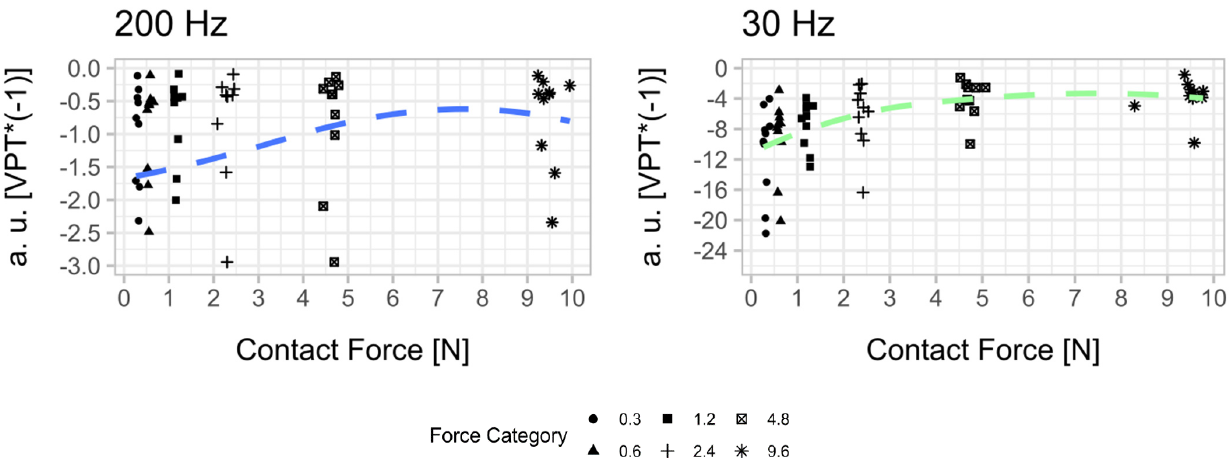
Figure A2. Psychophysical relationship between contact force and perceived sensitivity [VPT*( − 1)] in arbitrary units (a. u.) at 200 Hz and 30 Hz. The median was calculated for the three determined vibration perception thresholds (VPT) for each contact force condition per subjects. Thus, the scatter plots represent the whole sample size ( n = 10). A smoothed conditional mean was added using the R function “geom_smooth ()” in combination with the argument “method =